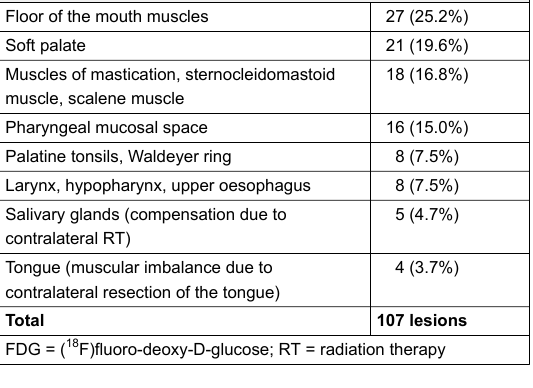
Table 3: Detailed information on all FDG-positive lesions considered physiological.